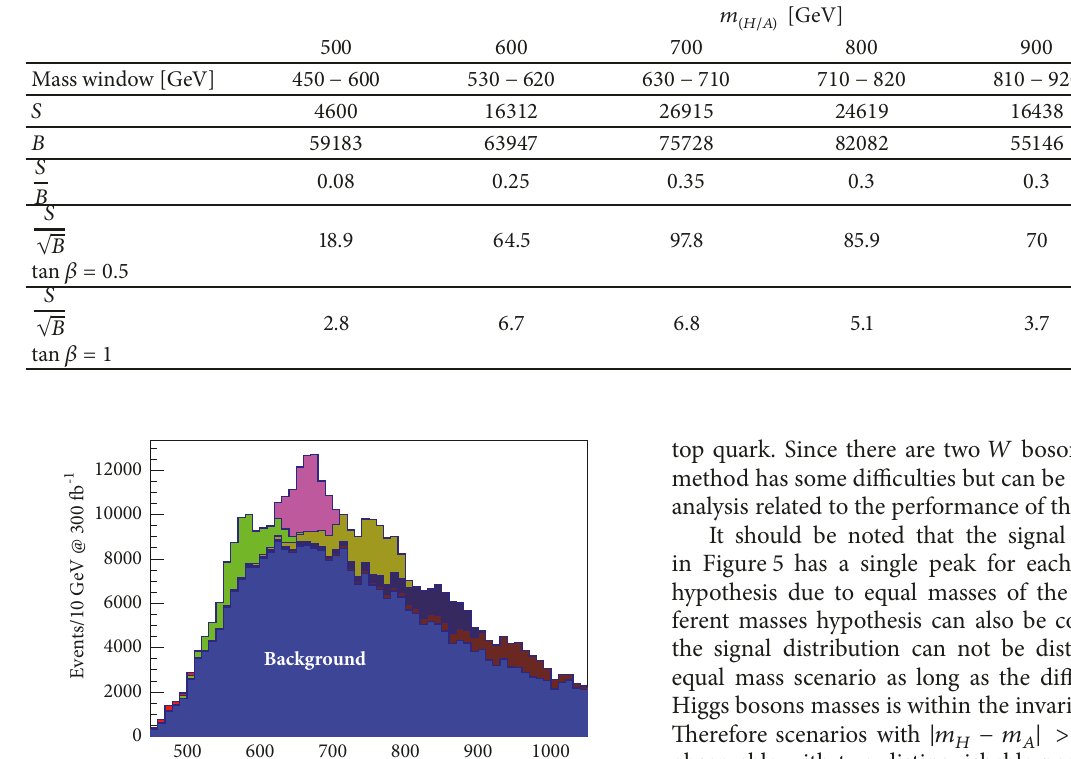
Table 5: Signal and background analysis results at tan 𝛽 = 0.5 and 1. The S and B denote the final number of signal and background events after the mass window cut.